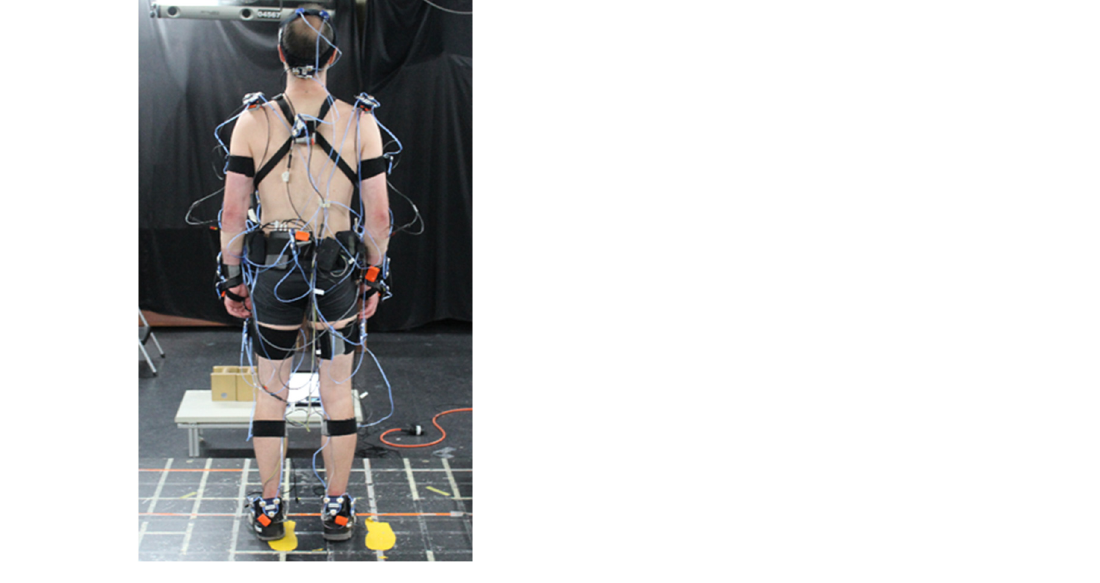
Figure 2. Experimental setup with the IMC system, the OMC system, and the force platform .